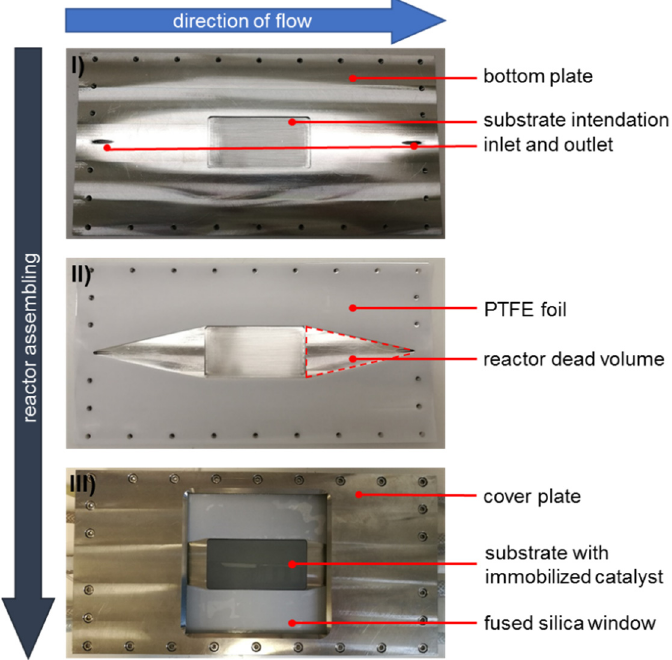
Figure 17. Overview of microgap reactor assembling. The described reactor dead volume ( II ) adds to the outlet connected tubing (not shown) to V dead ‐ volume ≈ 4 mL.